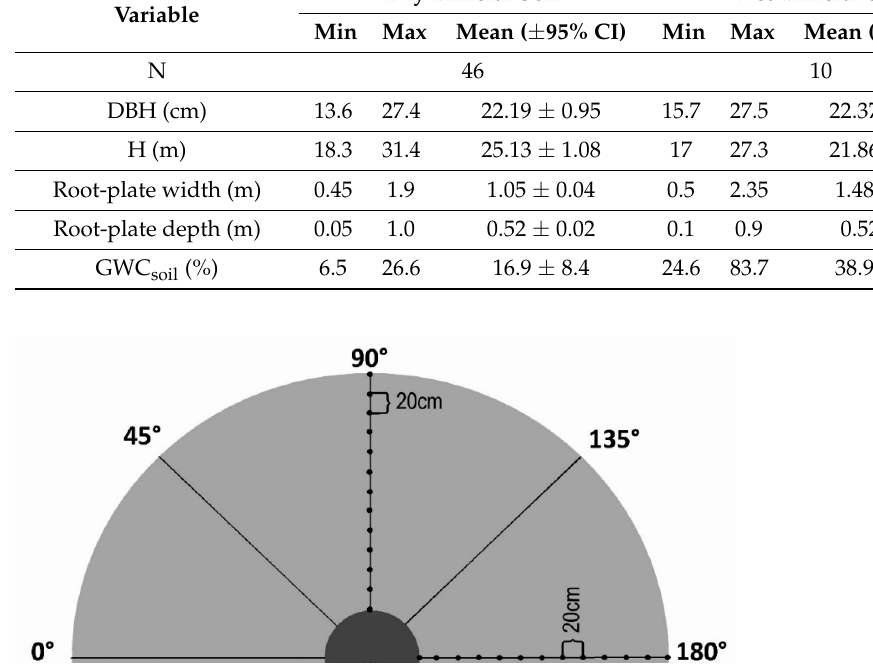
Table 1. Dimensions of sampled trees (N—number of samples, DBH—diameter at breast height, H —tree height, root-soil plate parameters (width and depth), and soil gravimetric water content (GWC soil ) in wet and dry mineral soils).